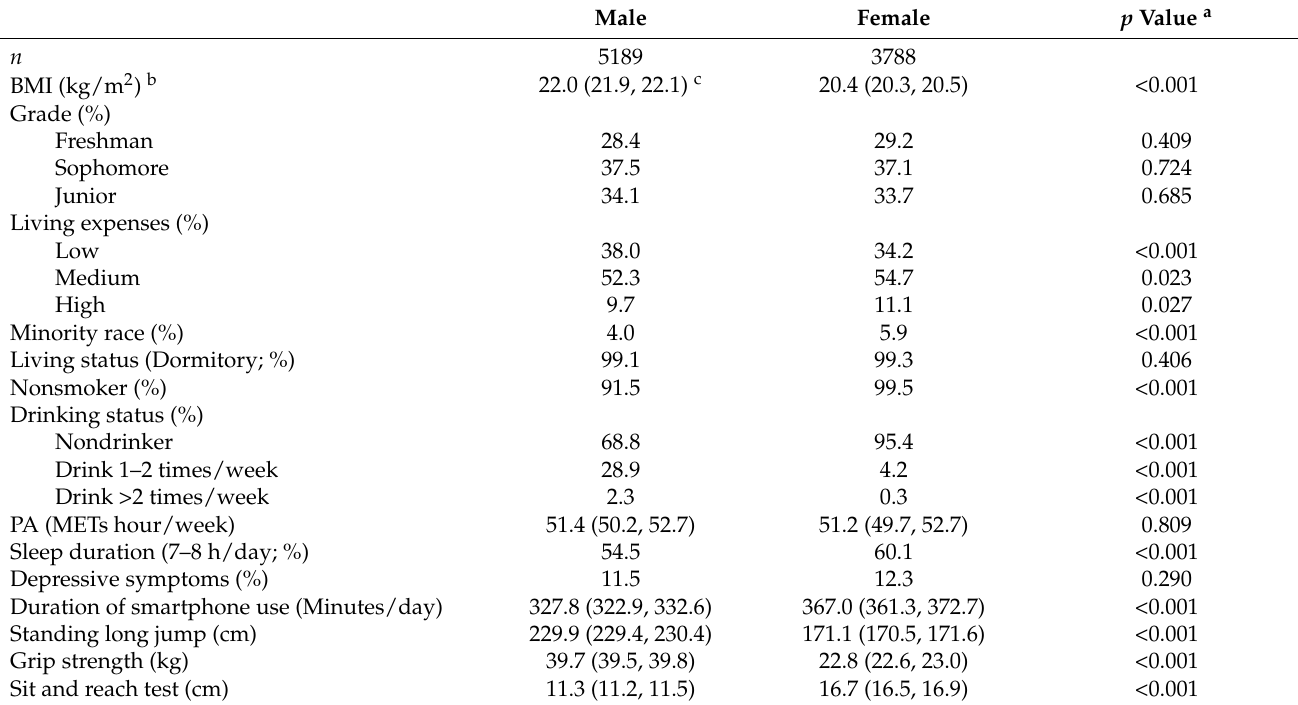
Table 1. Basic characteristics of male and female participants.